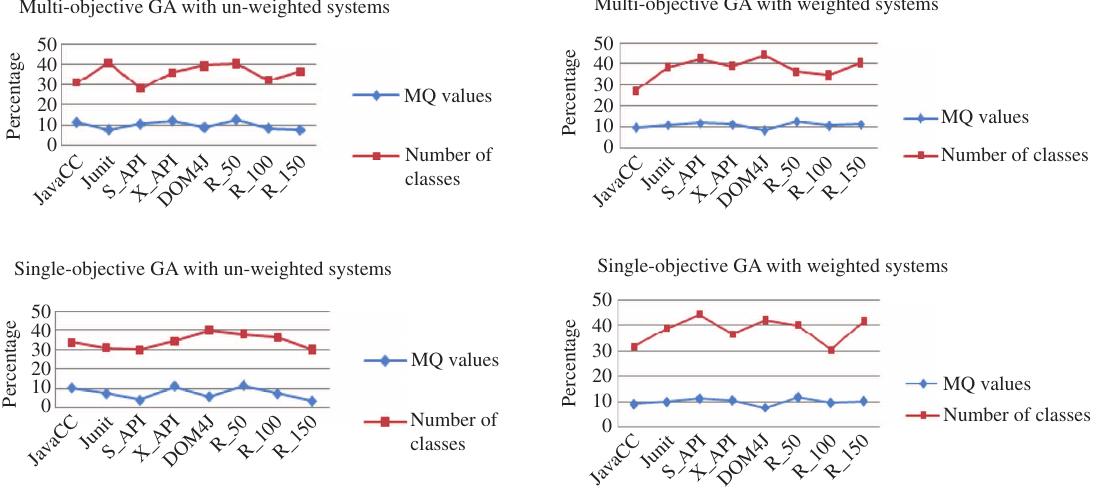
Figure 5: Percentage Reduction in the Number of Moved Class and MQ